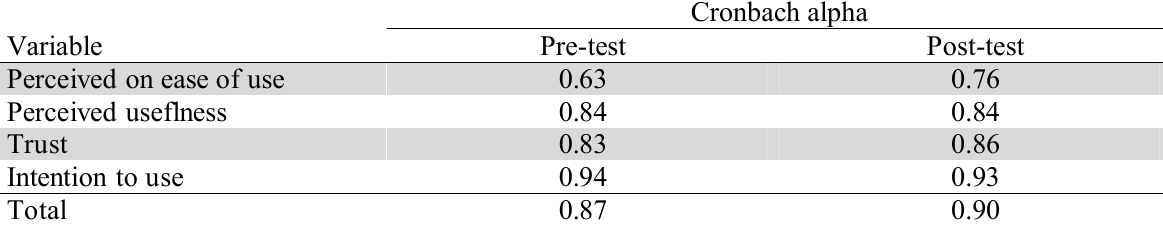
The summary of Cronbach